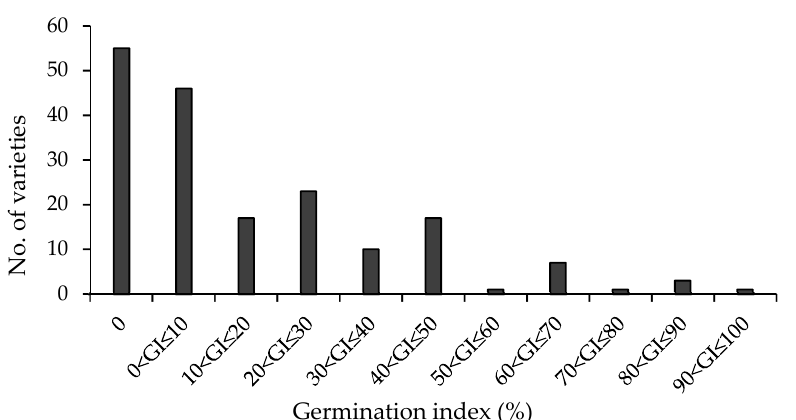
Figure 1. Frequency distribution of germination index of experimental varieties under the cold stress condition.